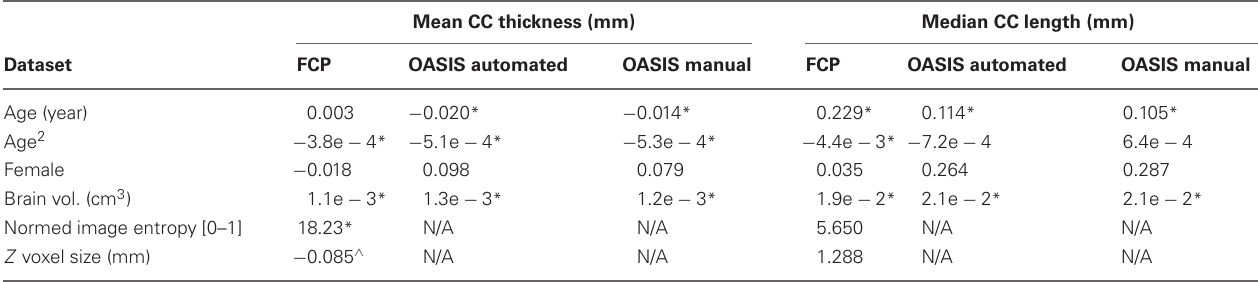
Table 5 | Regression equation coefficients computed using healthy subject FCP data from 25 groups and OASIS healthy control data, for both automatic and expert-corrected segmentations, and for overall thickness and median length (columns).